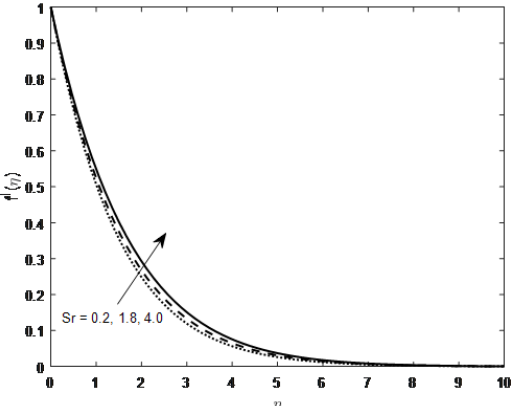
Figure 6: Velocity profiles for different values of Soret number Sr